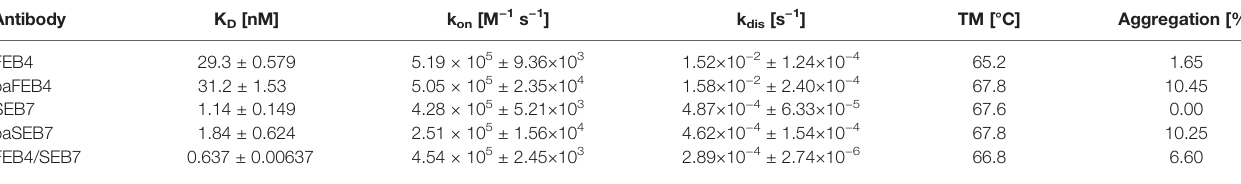
TABLE 1 | Biophysical properties of FEB4 and SEB7 variants including af fi nity, kinetic binding rates, melting temperature, and aggregation.